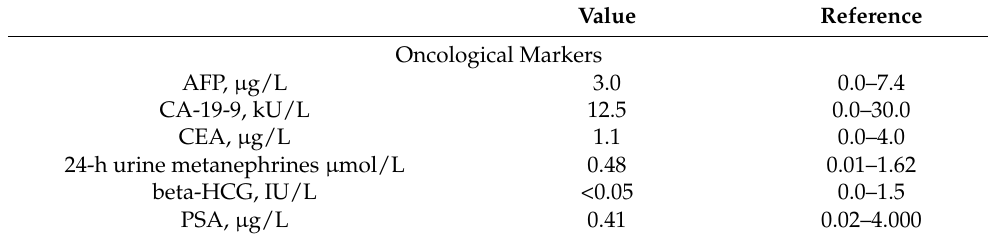
Table 2. Oncological markers.